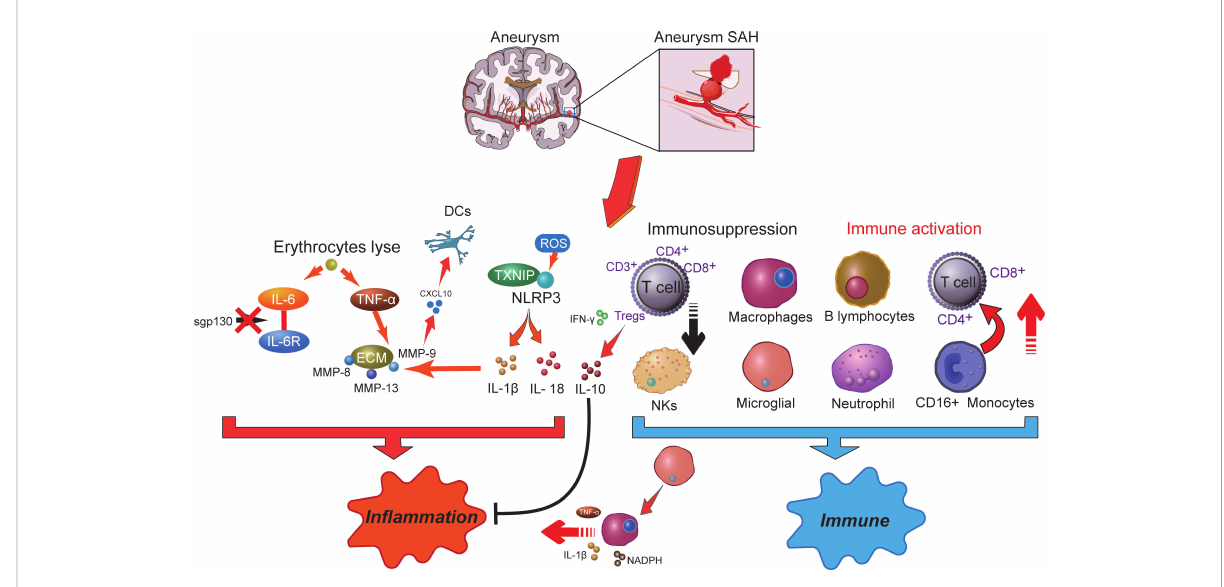
FIGURE 1 The potential molecular mechanisms of in fl ammatory effects (right) and immune responses (left) in aneurysm-related subarachnoid hemorrhage. SAH, subarachnoid hemorrhage; DCs, dendritic cells; IL-6, interleukin 6; ROS, reactive oxygen species; MMP, matrix metalloproteinases; NLRP3, NOD-like receptor family pyrin domain-containing 3; TXNIP, thioredoxin-interacting protein; TNF- a , tumor necrosis factor- a ; INF- g , interferon- g ; NKs, natural killer cells; NADPH, nicotinamide adenine dinucleotide phosphate oxidase; Tregs, regulatory T